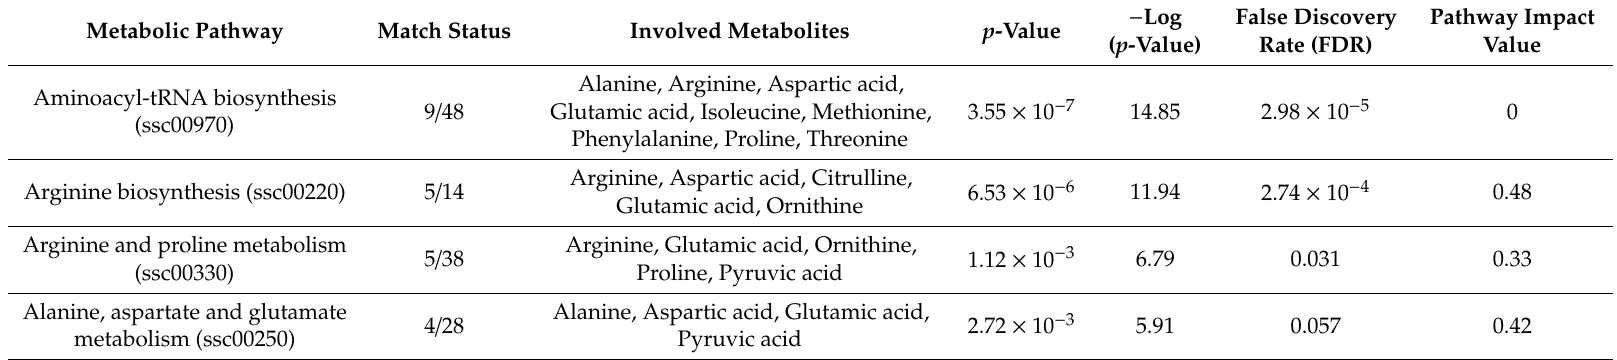
Table 1. Significant metabolic pathways (False Discovery Rate (FDR) < 0.1) using Homo sapiens as the